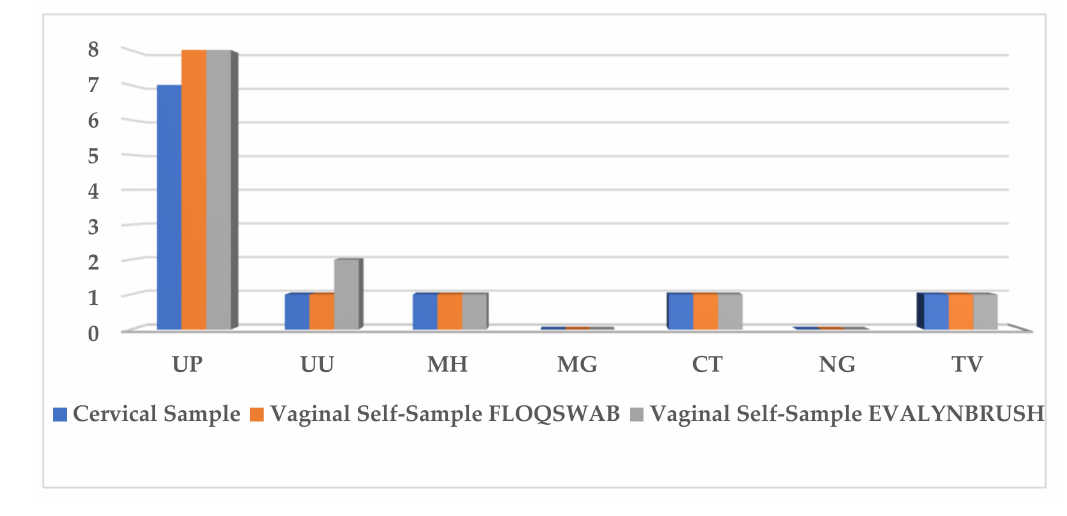
Figure 5. Prevalence of STIs pathogens in cervical samples and vaginal self-samples collected using FLOQSwabs ® (FS) and Evalyn ® Brush (EB). Seven STI pathogens were detected: Chlamydia trachomatis (CT), Neisseria gonorrhoeae (NG), Trichomonas vaginalis (TV), Mycoplasma hominis (MH), Mycoplasma genitalium (MG), Ureaplasma urealyticum (UU), and Ureaplasma parvum (UP). Table 3. Satisfaction questionnaire for FS, HS, and EB self-collection